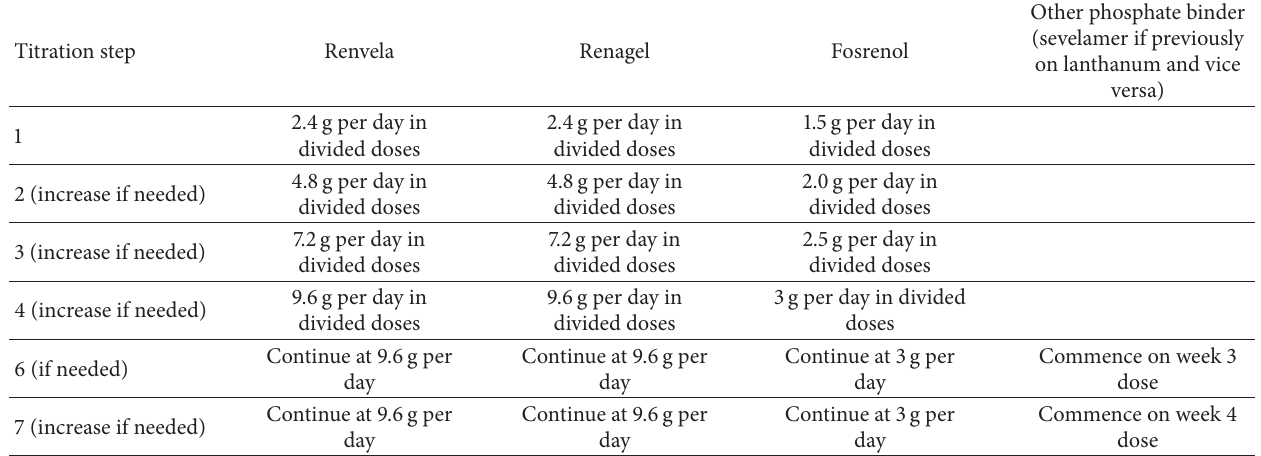
Table 3: Dosing schedule in the